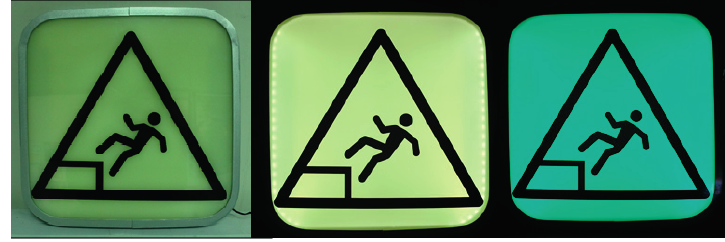
Figure 10. Uses of a Smart Signal with phosphorescent